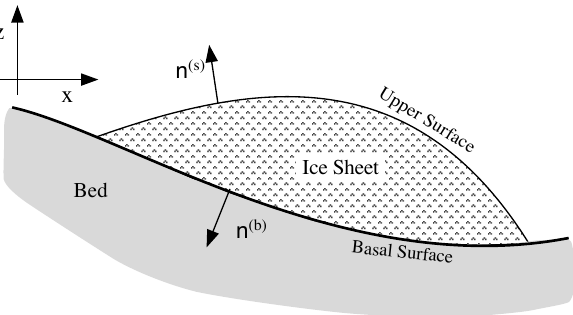
Fig. 1. A schematic diagram of the simplified ice sheet configura- tion considered in this